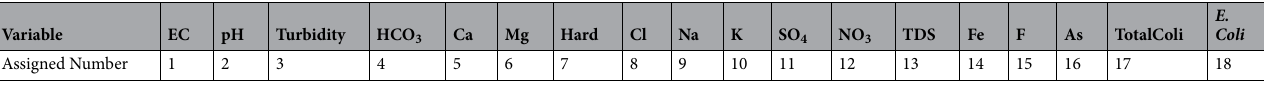
Table 2. Numbers assigned to variables for cluster analysis.